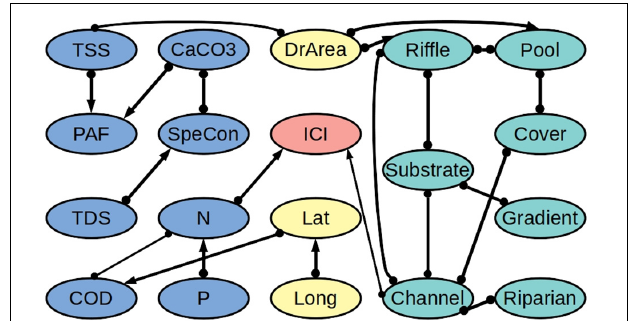
FIGURE 4 | Network of ecological relationships for the Invertebrates Community Index (ICI) in freshwater systems in Ohio, showing the relationships among the ICI (red), the water quality variables (blue), the physical habitat quality variables (turquoise), and the out-of-stream variables (yellow). Upstream variables are mainly connected to their downstream partners and are excluded from the figure to improve readability. The thickness of a connection indicates how many of the bootstrapping samples it appeared in. The abbreviations are explained in Table 2 . A summary of the bootstrapping results is provided in Supplementary Tables 4–6, 8